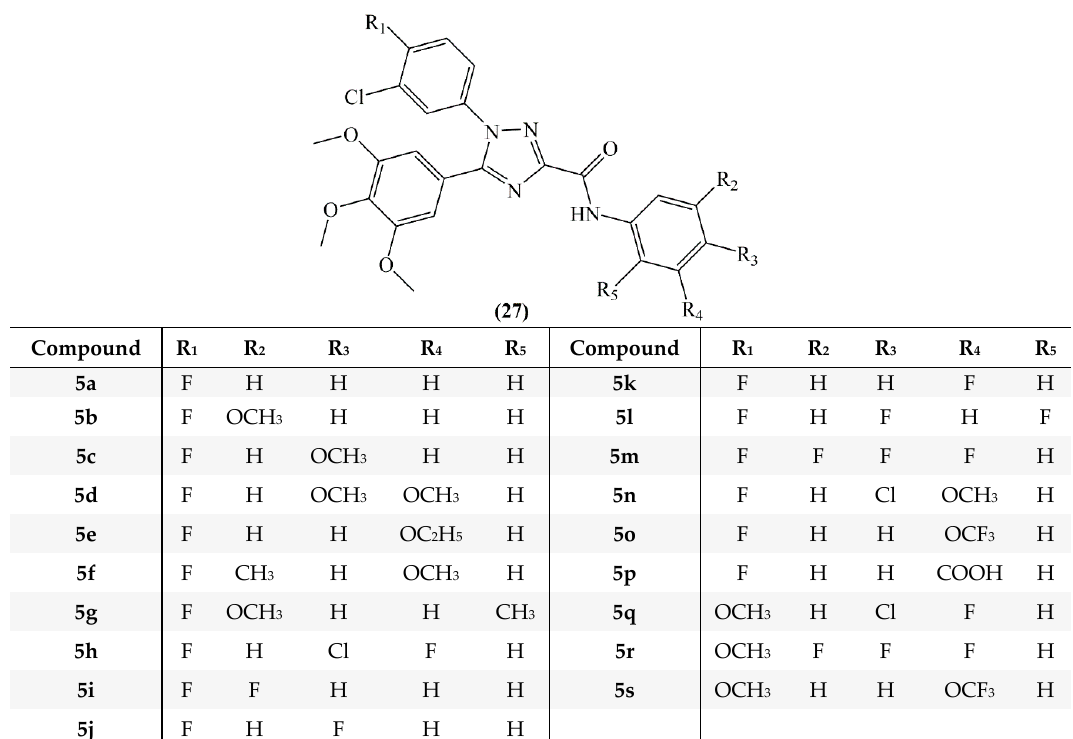
H Figure 13. Structures of compounds 6a – 6f . In a different study of Mustafa et al, 1,2,4-triazole-3-carboxamide analogs of combretastatin were